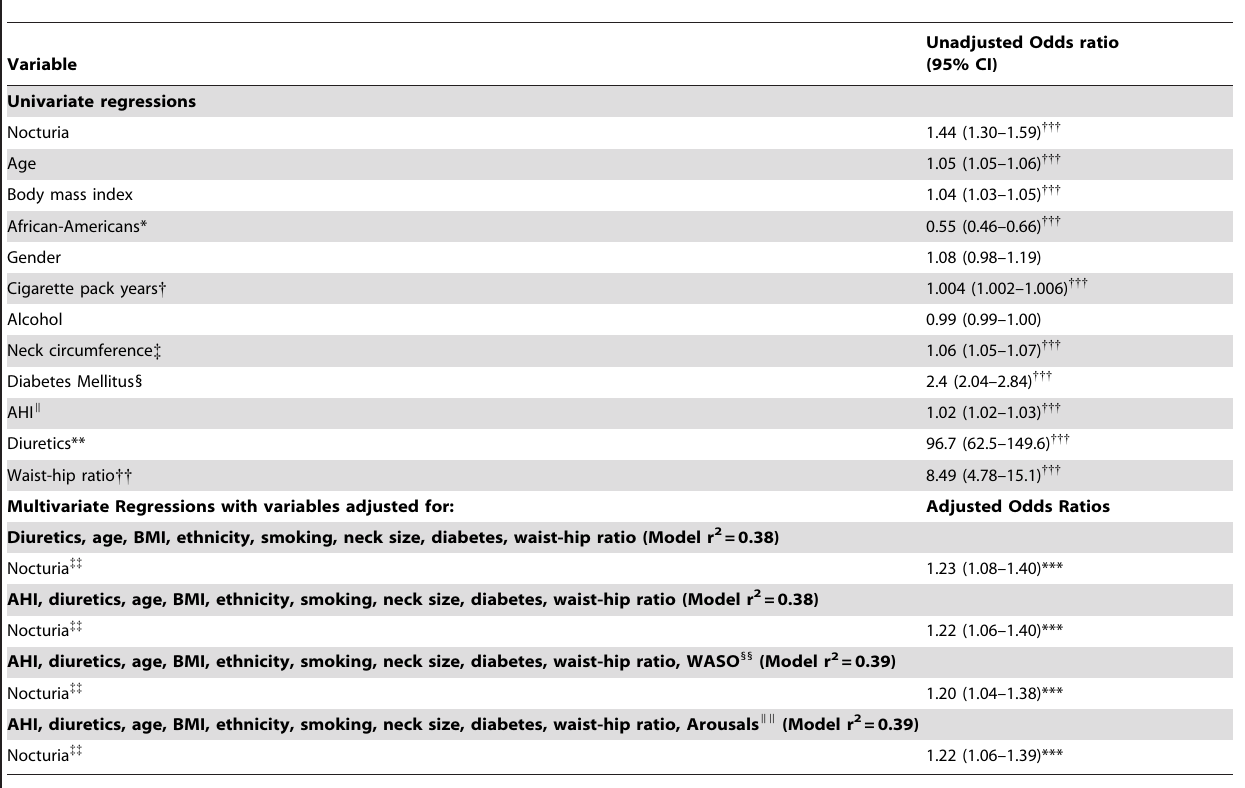
Table 4. Adjusted And Unadjusted Odds Ratios Of Associations with